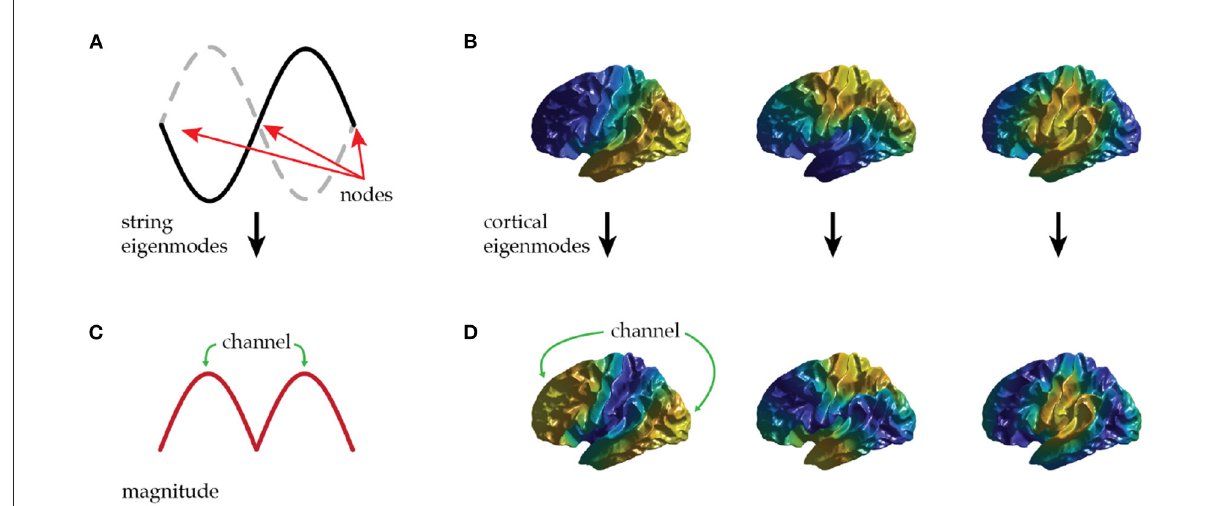
FIGURE2 (A) The first non-uniform eigenmode of a string contains three zeros (nodes) and two antinodes that oscillate in antiphase. (B) The first three non-uniform eigenmodes of the cortex—each has a single nodal line. (C) The local amplitude (magnitude) of the first non-uniform eigenmode of a string shows a possible communication channel between each antinode. (D) The local amplitude of the first three non-uniform cortical eigenmodes supports communication along rostrocaudal, dorsoventral, and mediolateral